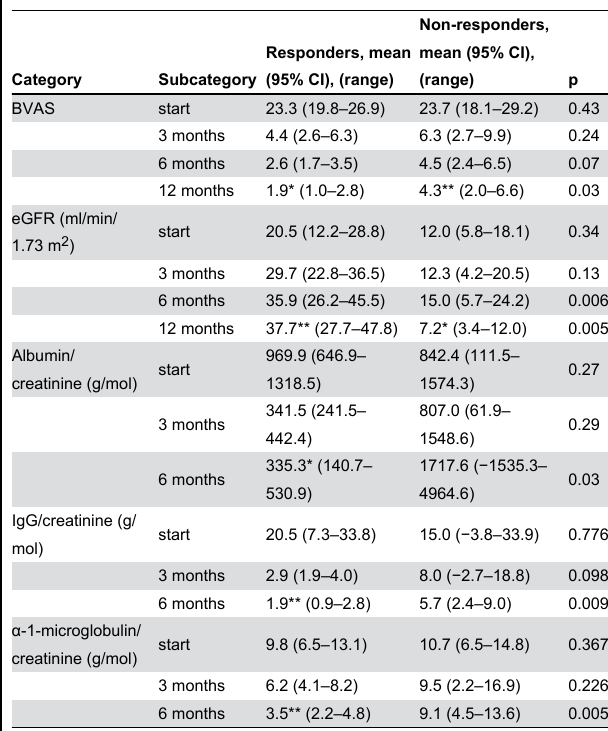
Table 2. Calculated BVAS score and eGFR at the time of diagnosis (start), 3, 6 and 12 months after induction therapy, and urine albumin to creatinine, IgG to creatinine, and α-1-microglobulin to creatinine in patients with ANCA- associated glomerulonephritis (responders and non- responders) at the time of diagnosis (start), 3 and 6